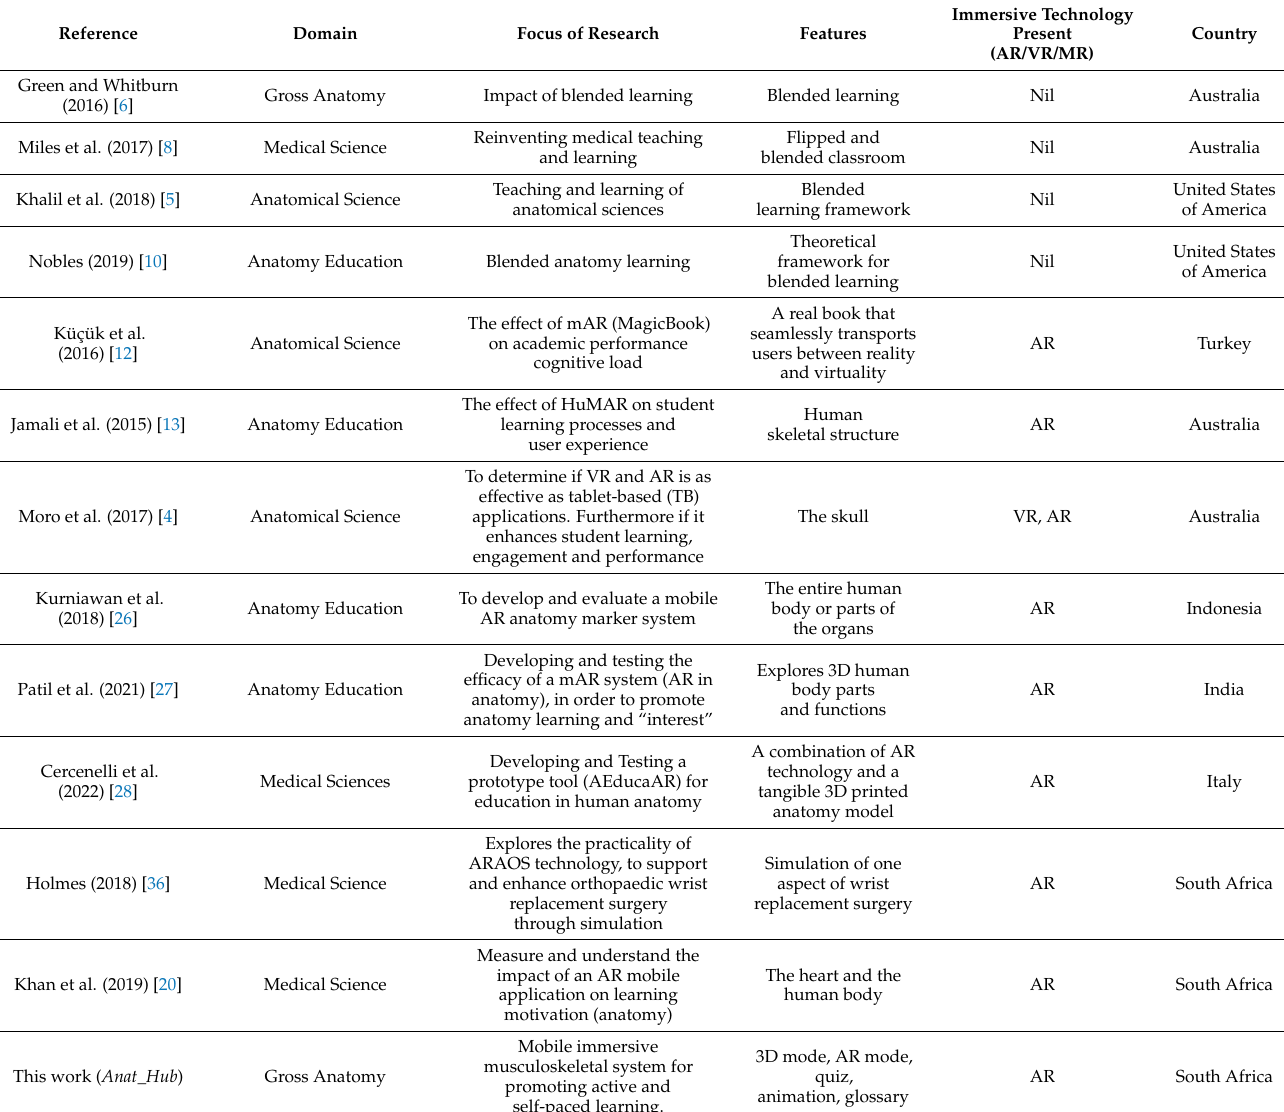
Table 1. The recent trend of blended learning with immersive mobile AR technologies in anatomy